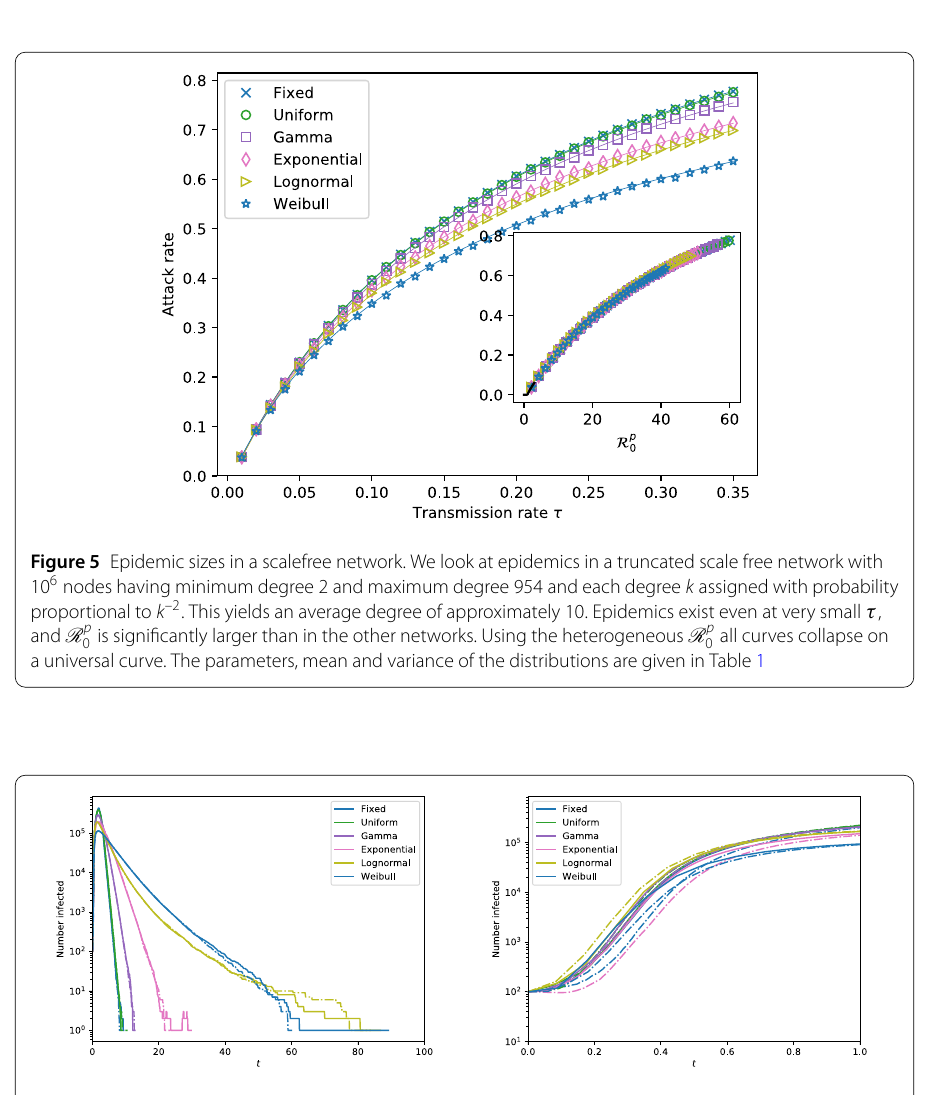
Figure 6 Dynamics of epidemics in scalefree network. Taking τ = 0.15, we show two epidemic curves for each distribution from Fig. 5. On the right we see the early dynamics. There is significant heterogeneity in the early growth, even for the same distribution. This is because the timing of rare infections to the highest degree nodes plays a significant role even in networks of 10 6